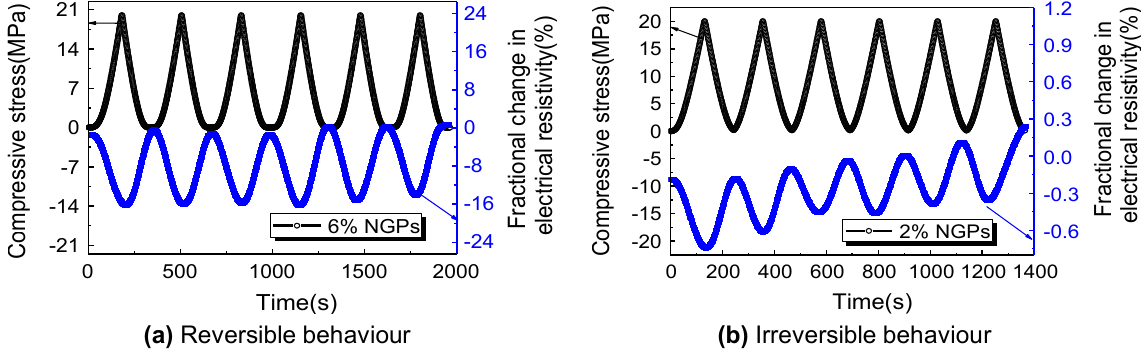
Figure 2. The difference between reversible and irreversible behaviours of electrical resistivity under compressive loading: ( a ) reversible behaviour; ( b ) irreversible behaviour [73]. The relationship between the volume resistivity and the volume resistance is calculated based on Equation (1).